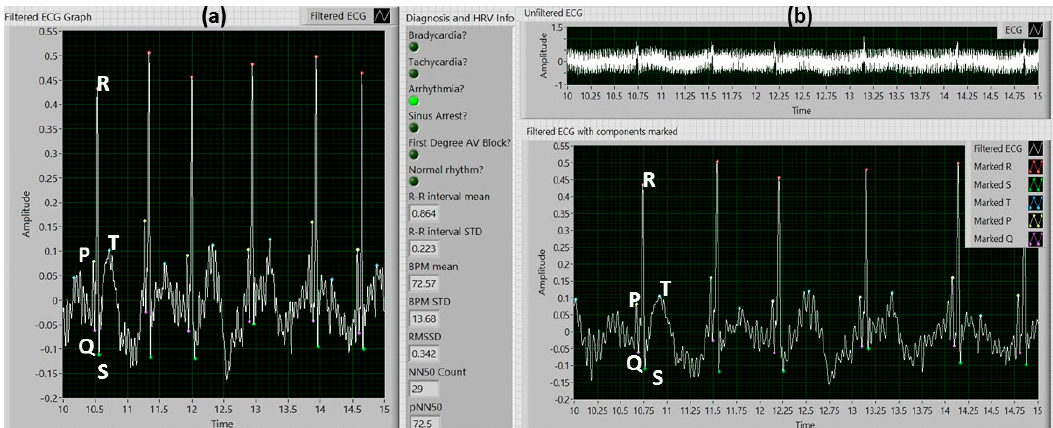
Figure 7. ( a ) Main program front panel with filtered ECG data, marked ECG components, and anomaly diagnosis information; ( b ) Unfiltered and filtered zebrafish ECG data with ECG components identified. Table 1. Summary table of anomalies detected in the ECG signal presented in Figure 7a. R-R Interval Number Anomaly/Anomalies 1–2 3–41